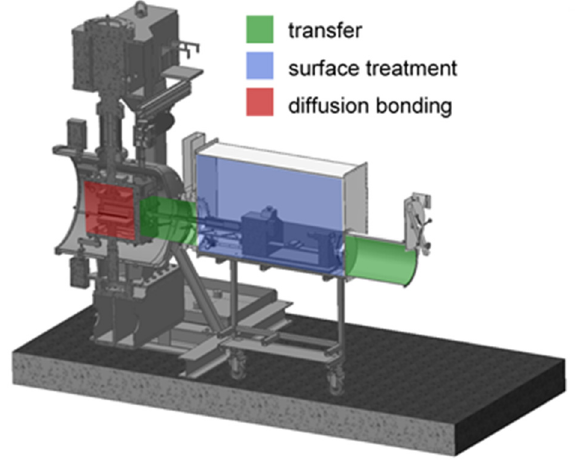
Figure 1. Sectional view of the technology for in-line surface treatment and diffusion bonding.